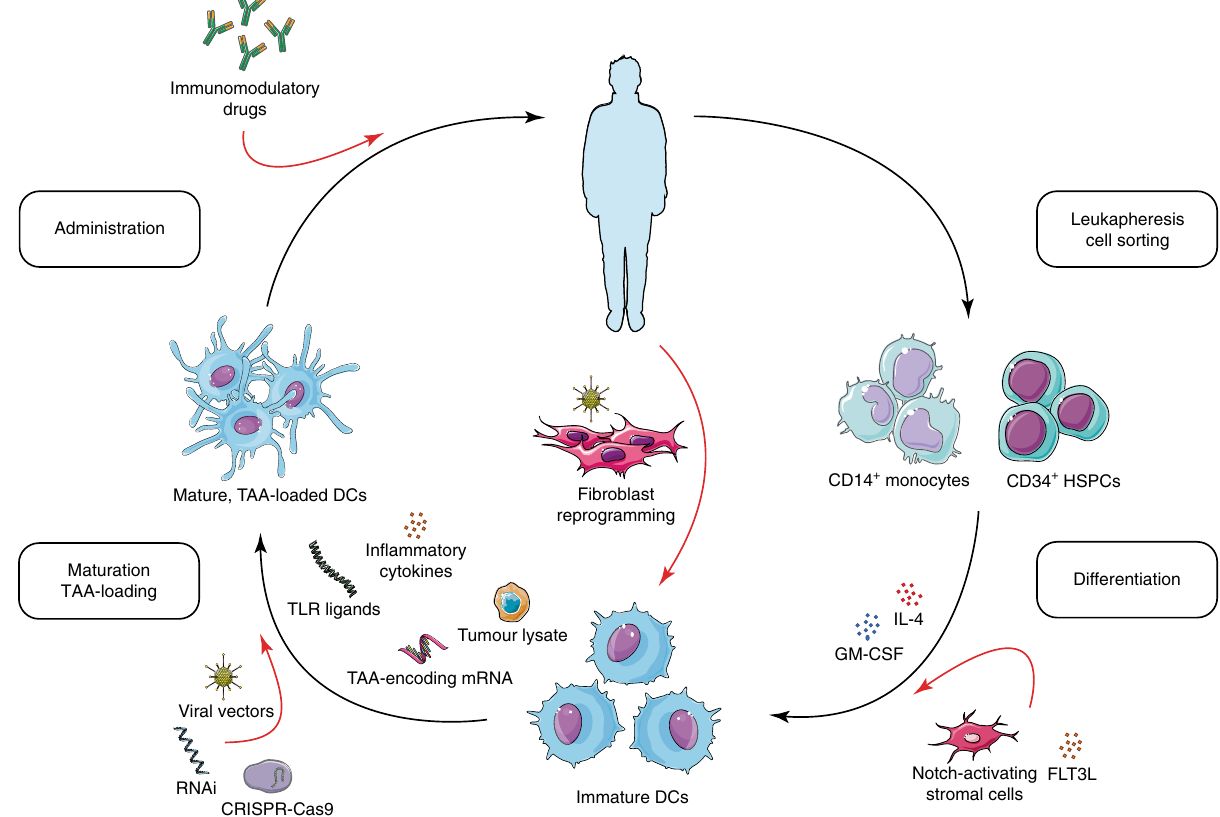
Fig. 2 Proposed manufacturing procedures for improving dendritic cell-based vaccines. Black arrows indicate conventional manufacturing steps, while red arrows indicate proposed modi fi cations or additions. CD14 + monocytes or CD34 + haematopoetic stem and progenitor cells (HSPCs) are isolated from leukapheresis products, differentiated into immature monocyte-derived dendritic cells (MoDCs) with IL-4 and GM-CSF. Alternatively, adult dermal fi broblasts are directly reprogrammed to conventional type 1 DCs (cDC1s) by lentiviral vector (LV) transduction of transcription factors without the need for leukapheresis 54 , or CD34 + HSPCs differentiated under FLT3L and Notch signalling to produce cDC1s at high yields 49,52 . The resulting DCs are then loaded with tumour-associated antigens (TAAs) of various forms and matured with toll like receptor (TLR) ligands or in fl ammatory cytokines. At this step, DCs could be genetically engineered to improve their anti-tumoural functions (see Fig. 1). Mature, TAA-loaded DCs are then re-infused to the patient, which could be combined with immunomodulatory drugs such as immune checkpoint